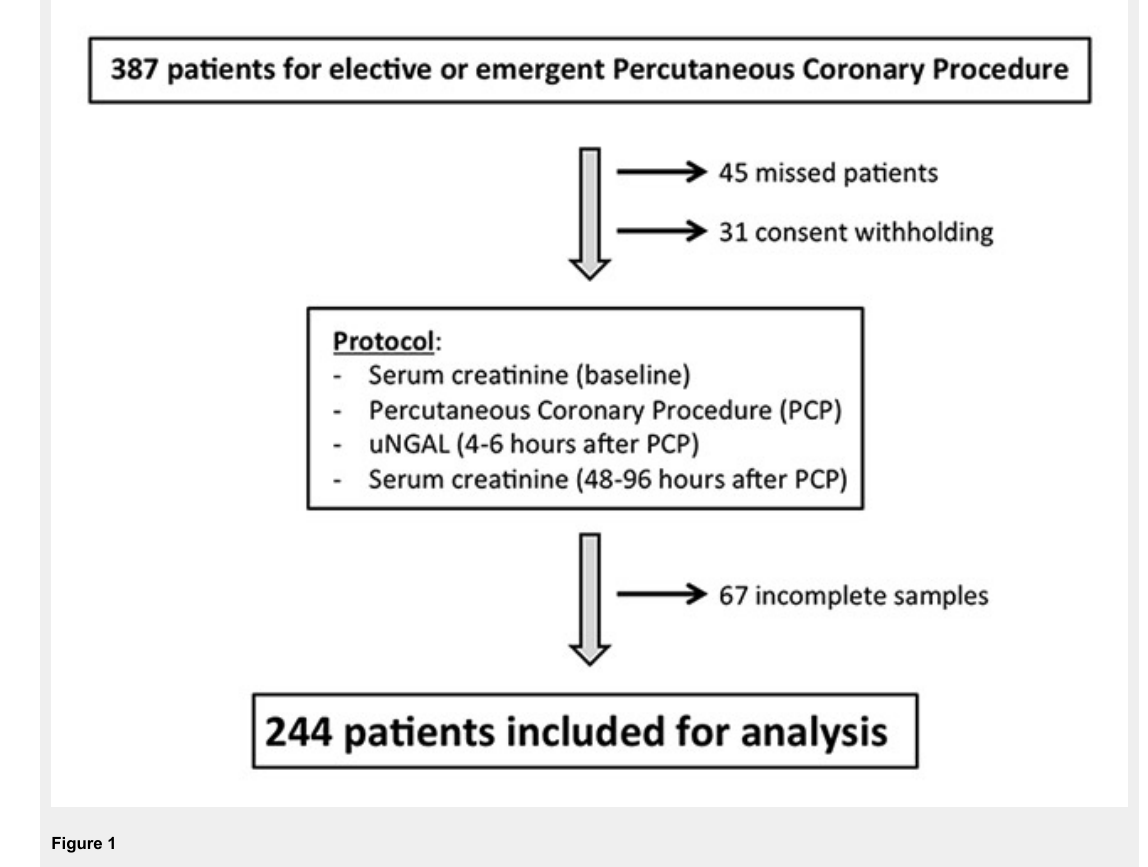
Figure 1 Study flowchart. uNGAL = urinary neutrophil gelatinase-associated